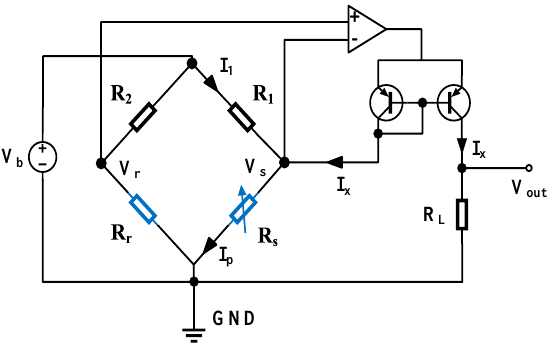
Figure 8. Constant-bias Wheatstone bridge circuit for the Pirani gauge operation [14].